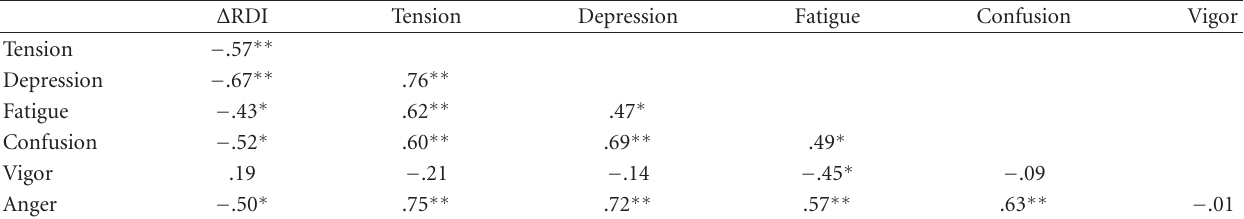
Table 2: Partial correlation coe ffi cients ( r ) (after controlling pre-CPAP AHI).